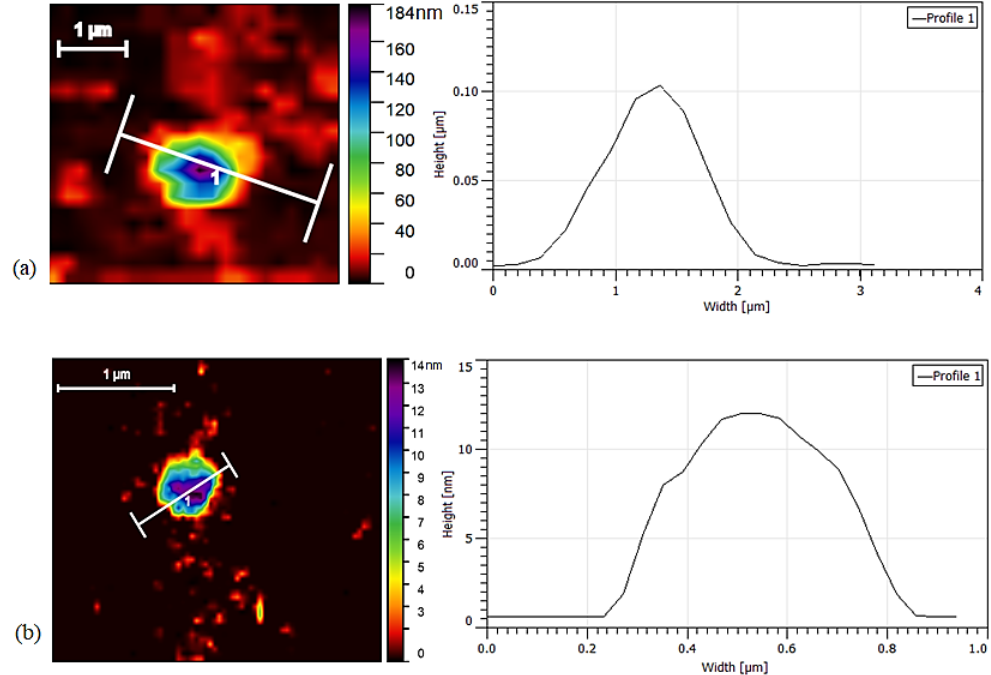
Figure 7. AFM topographic imagens of GO aqueous suspension and the height profile for a single GO sheet of: ( a ) 2 h and ( b ) 96 h of oxidation.